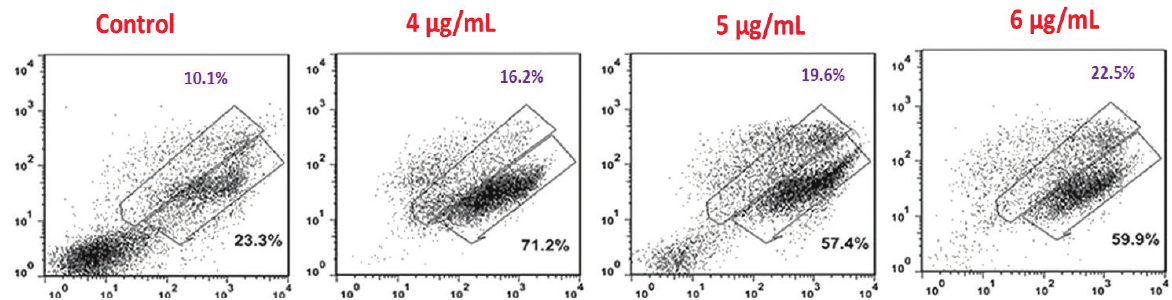
Figure 8: Flowcytometry profiles of Molt4 cells exposed with different concentrations of ZnO